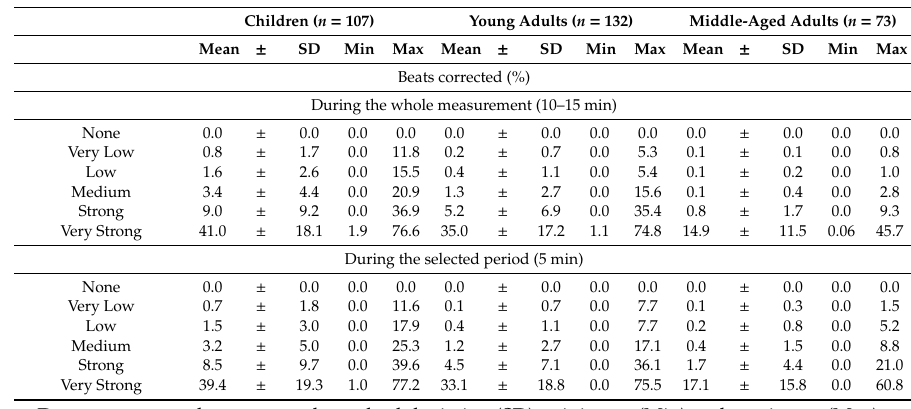
Table 2. Percentage of R-R intervals interpolated in the heart rate variability (HRV) measurements when using di ff erent Kubios